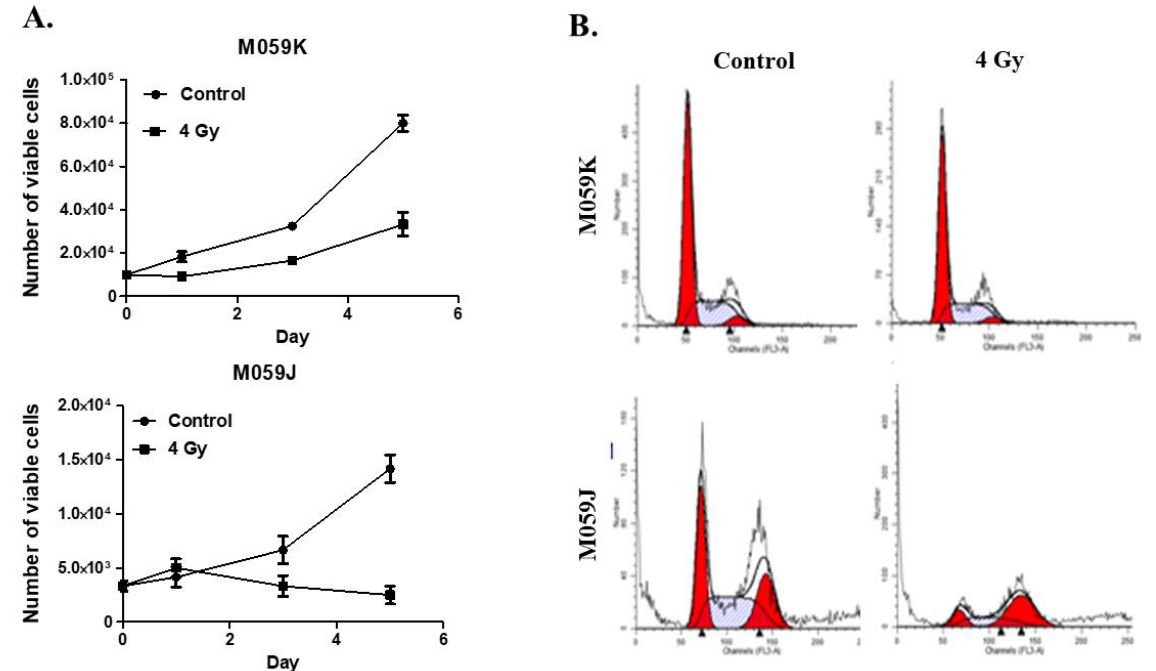
Figure 1. Radiation induces growth inhibition in repair-deficient cells but not in repair-proficient cells. ( A ) Exposure to radiation induces growth inhibition followed by delayed cell death in repair-deficient M059J cells (lower panel) but only delayed growth in repair-proficient M059K (upper panel). On day 0, cells were irradiated with 4 Gy and counted on days 0, 1, 3, and 5. Y axis represents the number of viable cell number as measured by trypan blue exclusion. ( B ) Cell cycle analysis showed that M059J cells were still growth-arrested at the G 2 /M phase of the cell cycle after 72 h of radiation, whereas M059K recovered their growth potential, showing a cell cycle distribution comparable to control, vehicle-treated cells. Consistently, cell viability results showed clear recovery in M059K cells but not in M059J cells, suggesting that deficiency in DNA repair due to lack of DNA-PKc function leads to prolonged growth inhibition upon radiation. Error bars represent standard error of the mean (SEM) in A.